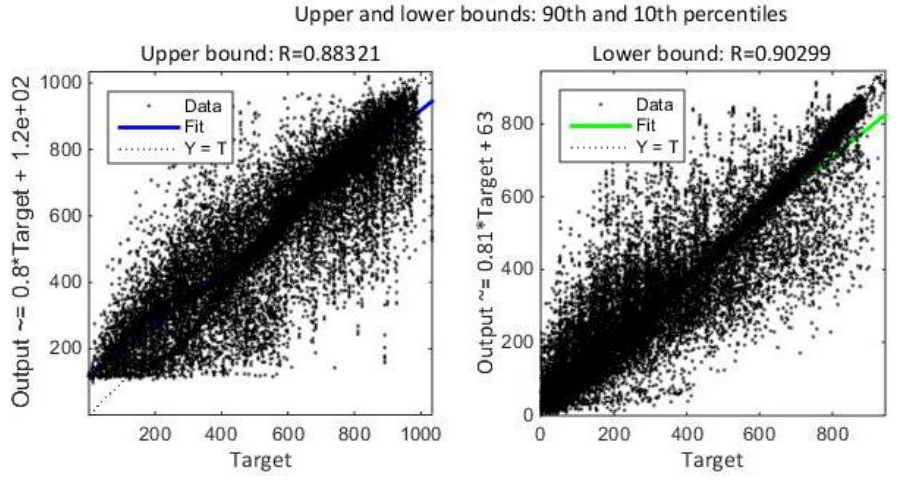
Figure 8. Comparison of ICP for all methods: ( a ) α = 90th and β = 10th percentiles, ( b ) α = 75th and β = 25th percentiles.